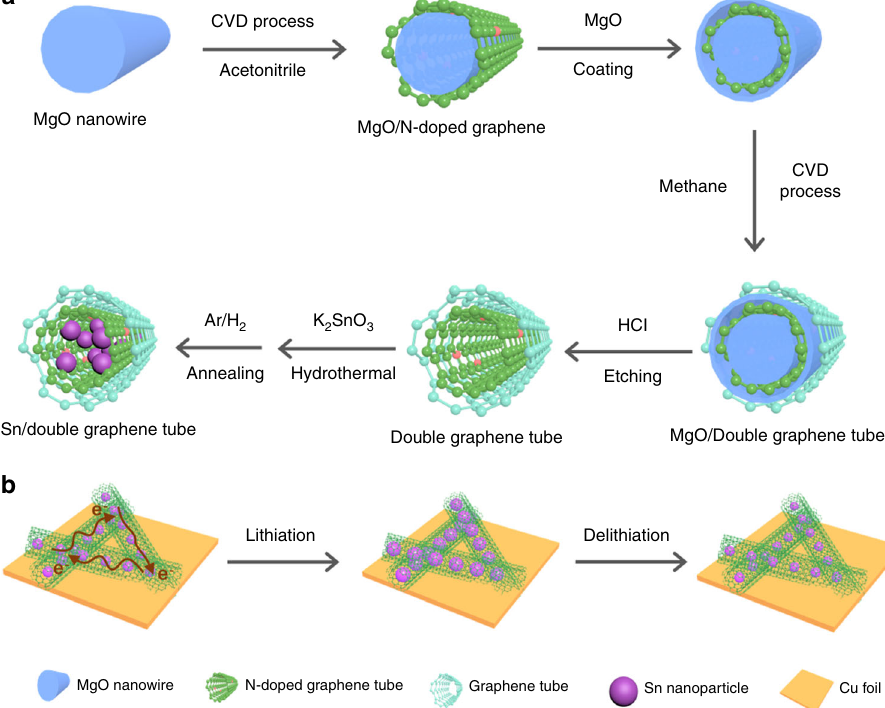
Fig. 1 A schematic illustrating the synthesis of Sn/DGT for high-performance anodes. a A schematic illustration of the synthesis of Sn/DGT composite. b A schematic illustration of the lithiation process of a Sn/DGT electrode, during which Sn nanoparticles are retained within the graphene tubes despite their large-volume change, preserving the electron-conduction networks and integrity of the